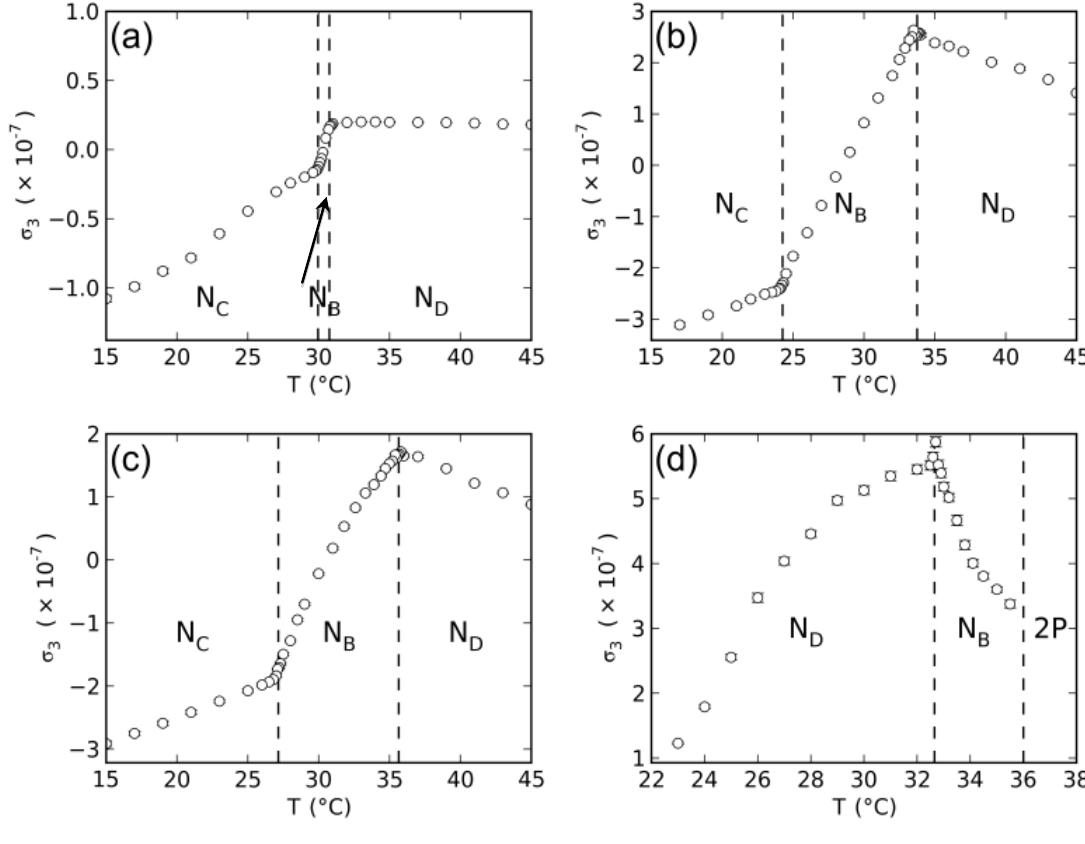
SO /DDeOH/water; ( b ) DL -KDDS/Na 2 4 SO /DDeOH/water; and ( d ) DL -NaDDAs/Cs 2 4